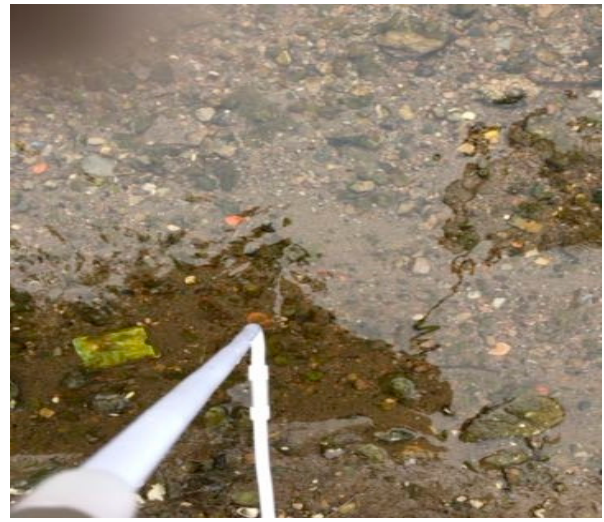
Figure 7. Image captured by the iPhone 6s.